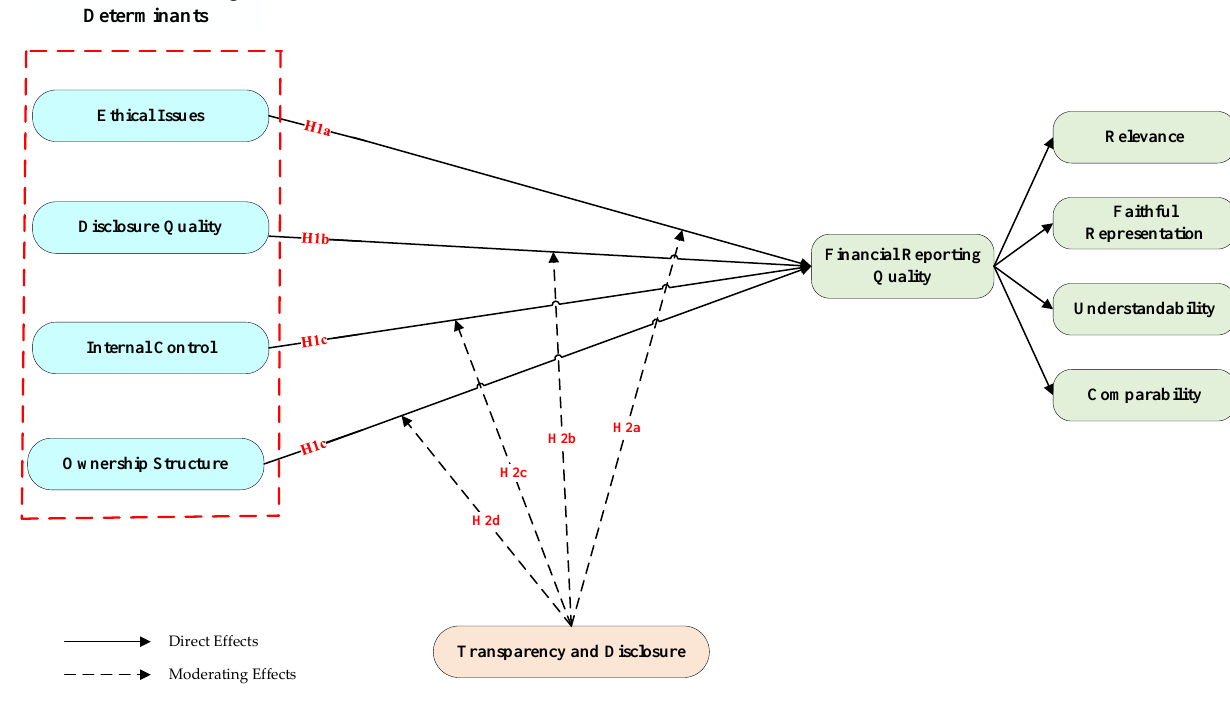
Figure 1. Conceptual framework of the present study.